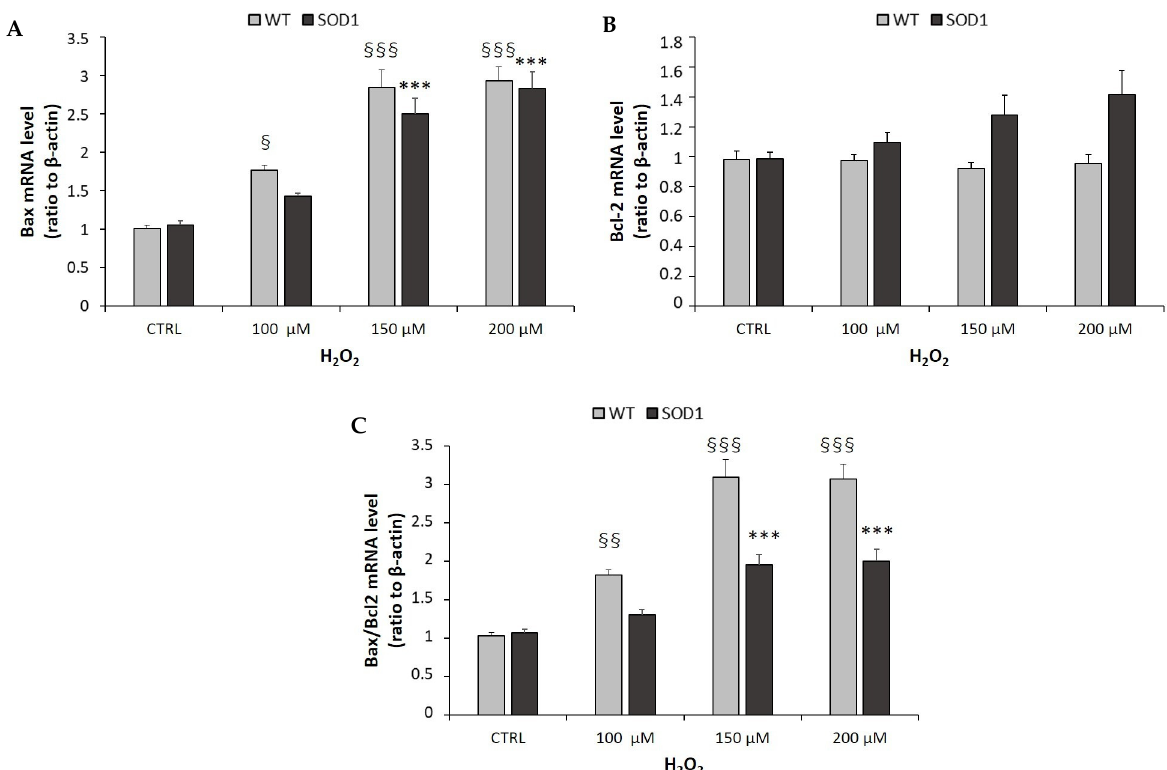
Figure 5. Quantification of mRNA levels of apoptosis markers following H 2 O 2 exposure. SH-SY5Y WT and SOD1 G93A cells were plated at a density of 200,000 cells/well in 24-well plates and treated with different concentrations (0, 100, 150, 200 µM) of H 2 O 2 alone for 24 h. After treatment, the mRNA expression of Bax ( A ) and Bcl-2 ( B ) was assessed by Real-Time PCR using β -actin as house-keeping gene. ( C ) Quantification of Bax/Bcl-2 ratio. Data are expressed as mean ± SEM of 18 replicates obtained in 3 independent experiments (n = 6 in each experiment). For SH-SY5Y WT: § p < 0.05, §§ p < 0.01, §§§ p < 0.001 vs. CTRL; for SH-SY5Y SOD1 G93A : *** p < 0.001 vs. CTRL.